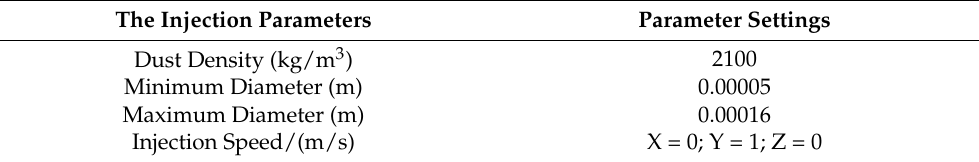
Table 3. Discrete phase settings.